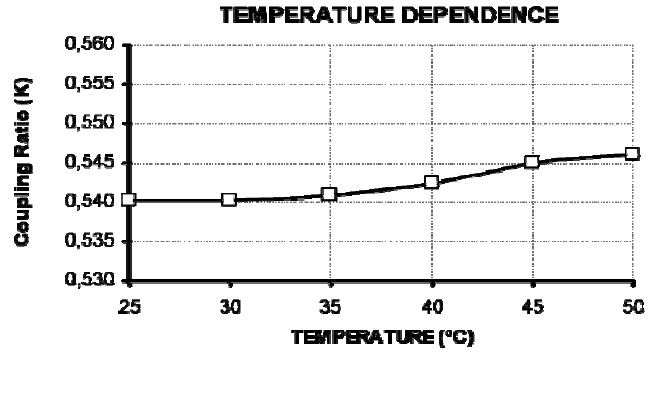
Figure 7. Temperature dependence of the coupling ratio of the sensor (from T = 25 ºC to T = 50